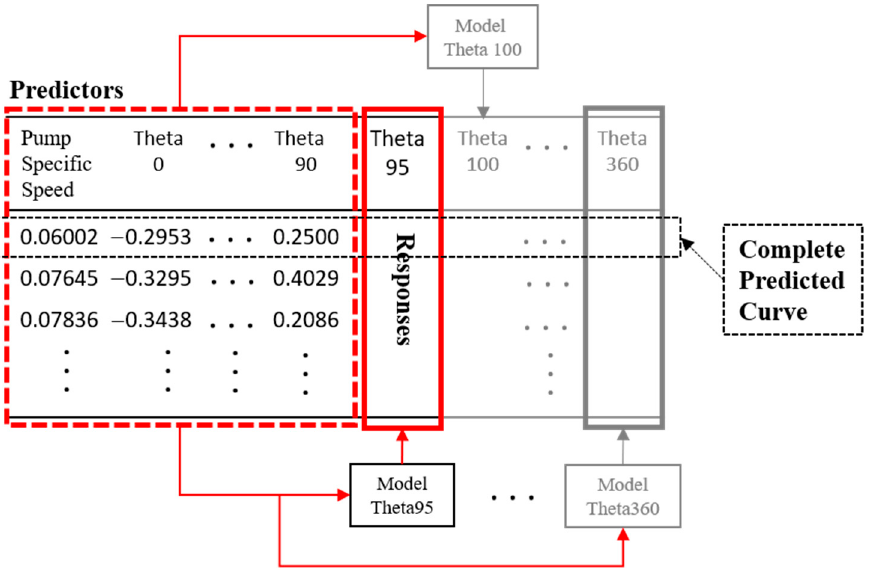
Figure 4. ML prediction